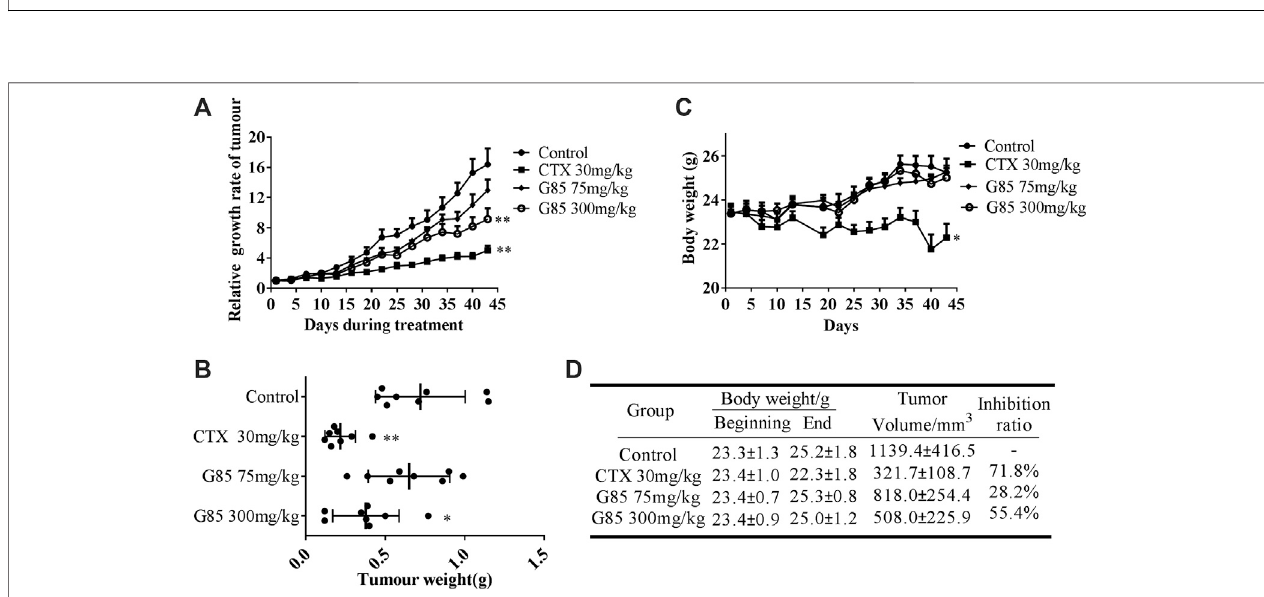
FIGURE 7 | The antitumor effect of G85 in the SK-Hep1 cell xenograft model in vivo . (A) The tumor growth curve, drawn according to the average percentage change of the tumor volume (B) The tumor weight of SK-Hep1 xenograft at the end of treatment in each group ( n (cid:2) 8). (C) The curve of mouse body weight measured every 3 days (D) Data of body weight before and after course of treatment and tumor inhibition at the end of treatment. Data were shown as mean ± SD.* p < 0.05, ** p < 0.01, vs control.